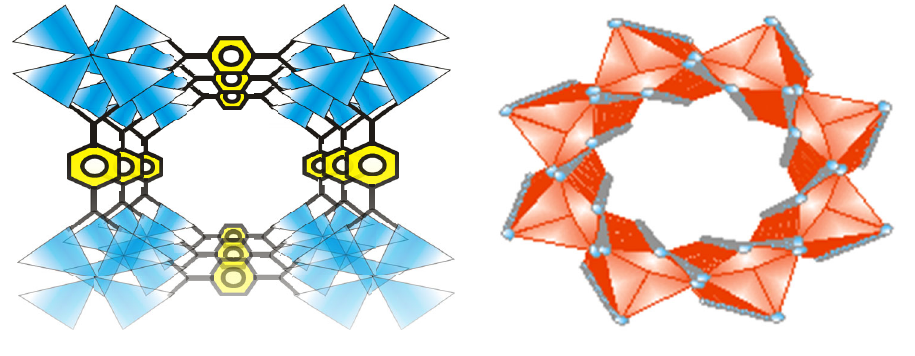
Figure 3. Typical structures of metal–organic frameworks with different metal salt and linkers.